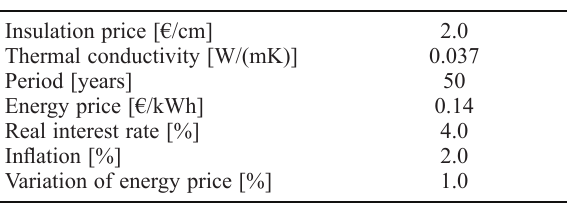
Table 4. Example case inputs